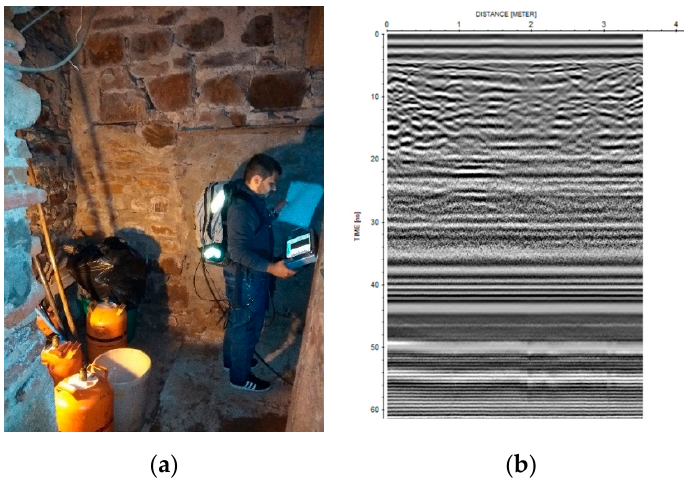
Figure 11. ( a ) Field work photography; ( b ) radargrama obtained in one of the walls with when attempting to obtain the thicknesses of wall and hidden cavities.